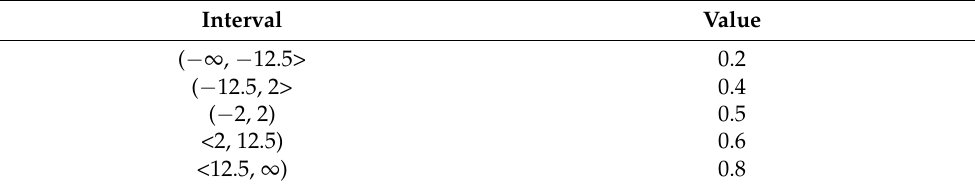
Table 5. Values of the ‘state’ variable in individual ranges of different currents of feed drive motors. Interval Value